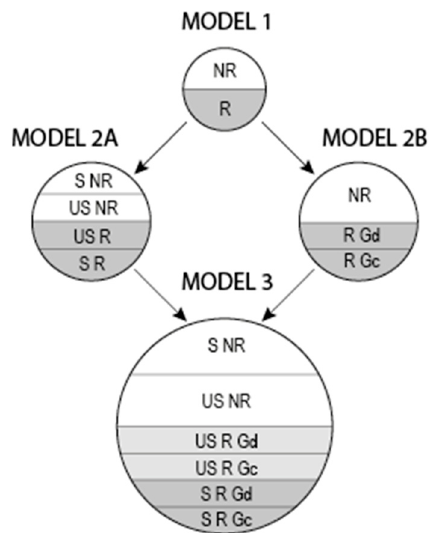
Figure 1. Categorisation of respondents according to religious affiliation combined with perceived closeness to God and stability of religious attitudes. NR: non-religious; R: religious; S: stable; US: unstable; Gd: perceiving God as distant; Gc: perceiving God as close.